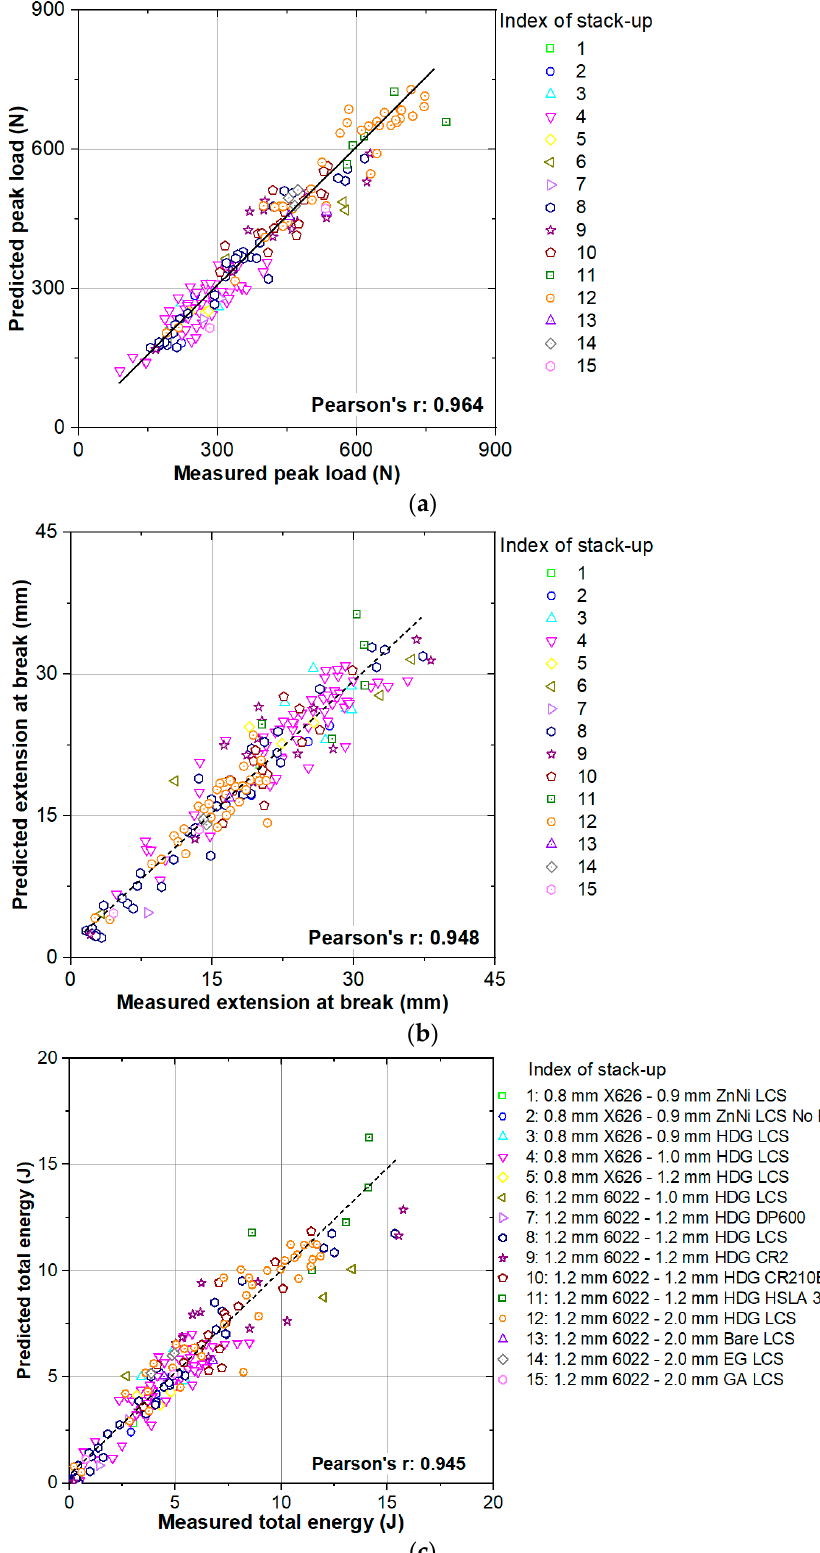
Figure 2. Comparison between ML predicted and experimentally measured ( a ) peak load, ( b ) extension at break, and ( c ) total energy, respectively, for validation testing welds only.